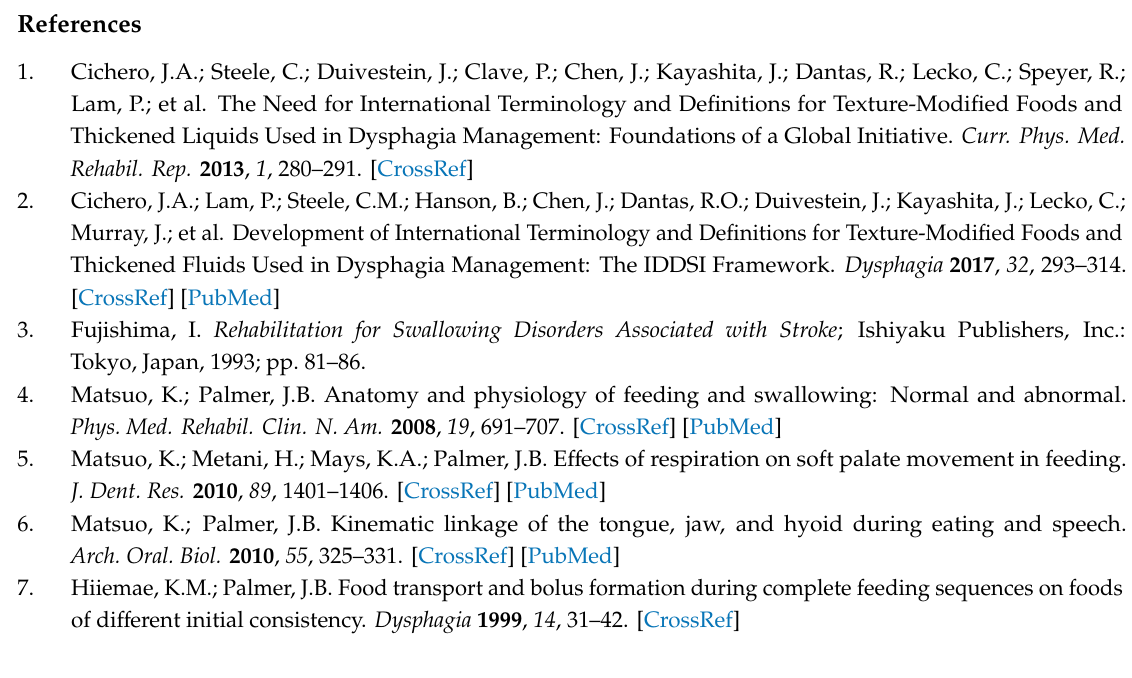
Figure 13. The proper combination of food, posture, and rehabilitation technique is important for safe swallowing and errorless